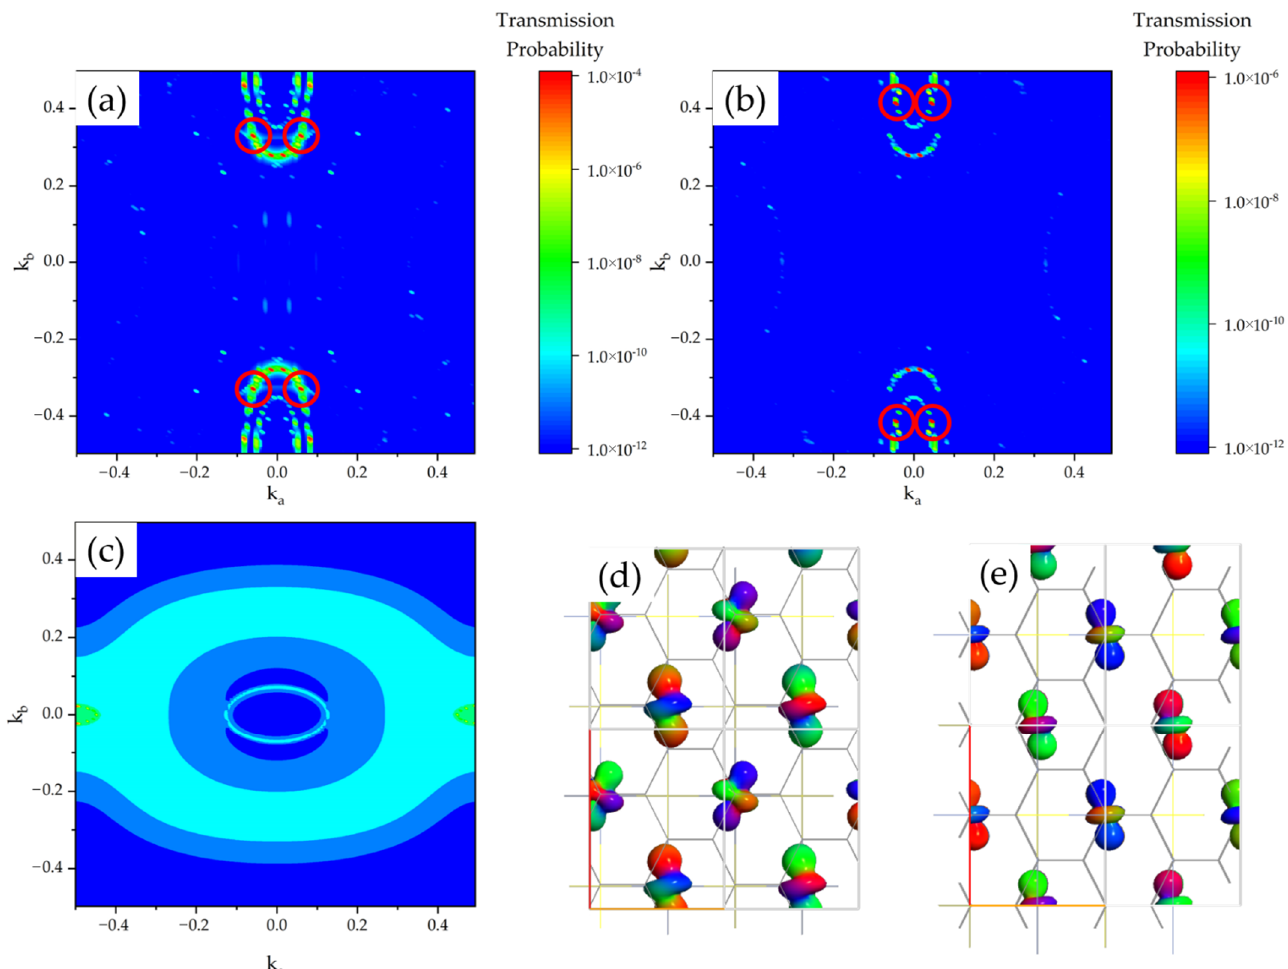
Figure 7. ( a ) Transmission spectrum of up states in 4-layer sf-MTJ under PC; ( b ) Transmission spectrum of up states in 6-layer sf-MTJ under PC. The spots with highest transmission probabilities are circled by red; ( c ) Transmission spectrum of graphene electrodes. Transmission spectra in the figure represent the transmission probabilities of electrons with different transverse Bloch wave vectors; ( d , e ) The transmission eigenstates of the spots with highest probability in ( a , b ) from the c axis perspective. The figures are the calculated results of the modeling.